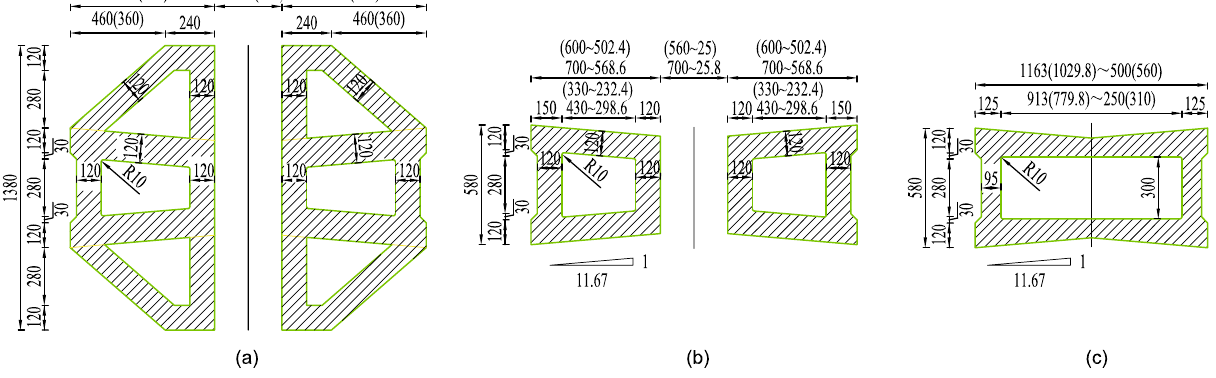
Figure 3. Sections of the pylon: ( a ) standard section of lower part of the pylon; ( b ) standard section of middle part of the pylon; ( c ) standard section of upper part of the pylon. (Unit:cm).